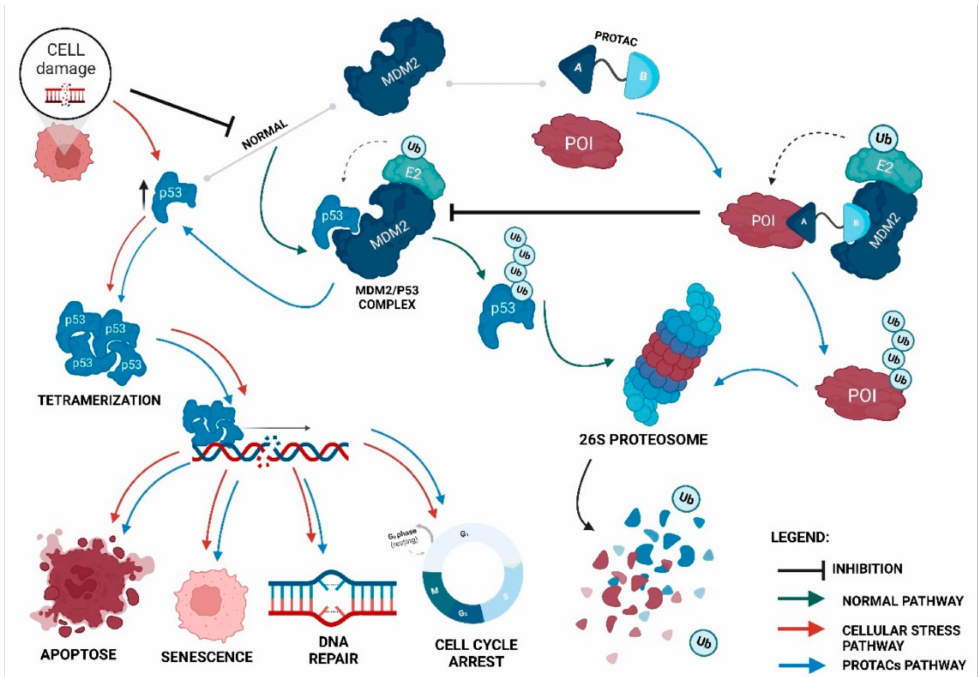
Figure 4. The impact of MDM2-based PROTACs on the MDM2/p53 cycle. Under normal conditions, p53 levels are kept low due to the presence of the MDM2 E3 ligase, which, when binding to the tumor suppressor, promotes its polyubiquitination, being subsequently recognized by the 26S proteasome, and degraded. When cell damage occurs, p53 is stabilized and forms a tetramer, and its ubiquitination by MDM2 is prevented. The tetramer is transported towards the nucleus, where it activates the transcription of those genes responsible for the processes of apoptosis, senescence, DNA repair, and cell-cycle arrest. However, in the presence of an MDM2-based PROTAC, when recruiting MDM2, this prevents it from binding to its natural substrate, p53, increasing the levels of the suppressor, which culminates not only in the degradation of POI, but also in the activation of processes that prevent the development of cancer cells